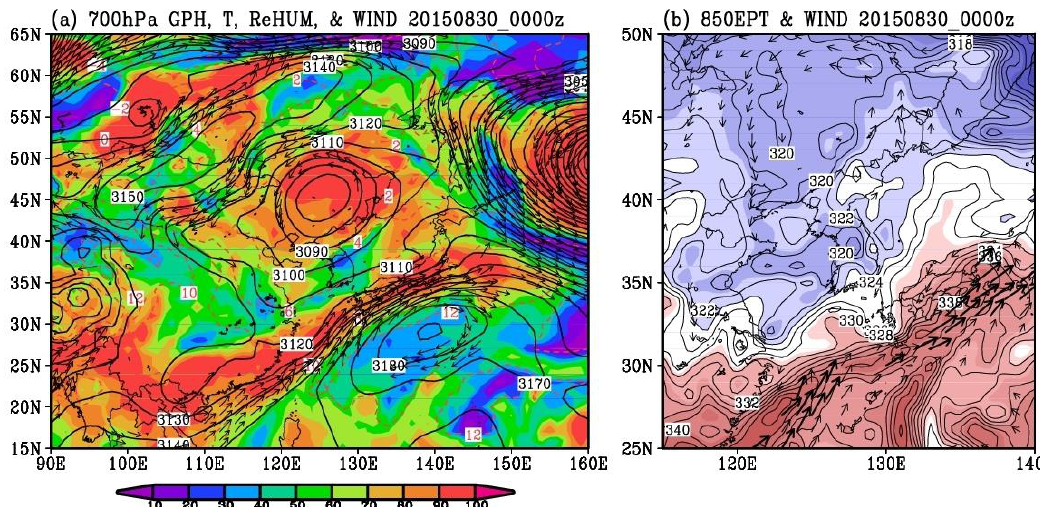
Figure 7. Weather charts at 00:00 UTC 30 August 2015: ( a ) 700-hPa geopotential height (contoured at 10 gpm intervals with solid lines), temperature (contoured at 2 °C intervals with red dashed lines), relative humidity (shaded rainbow colors), and wind > 8 m/s (vector); and ( b ) 850-hPa equivalent potential temperature (blue shaded below 324 K and red shaded over 330 K), wind > 5 m/s (vector), and wind > 12.5 m/s (bold vector).